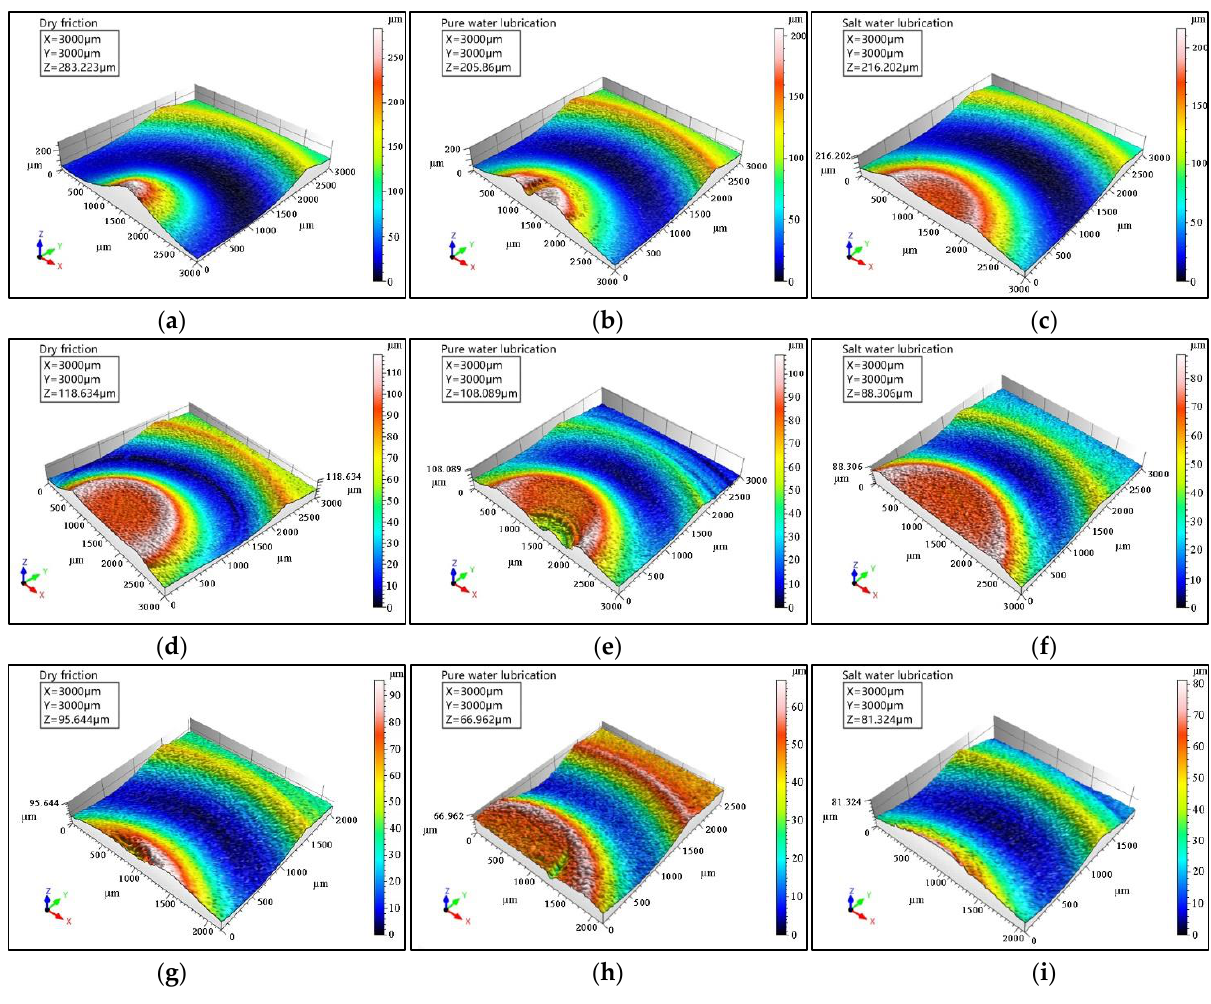
Figure 11. Three-dimensional surface morphologies of UHMWPE under dry friction, water-unsatu- rated lubrication and saltwater-unsaturated lubrication conditions: ( a – c ) 110 N load and 500 r/min speed, ( d – f ) 50 N load and 1100 r/min speed, and ( g – i ) 50 N load and 500 r/min speed.